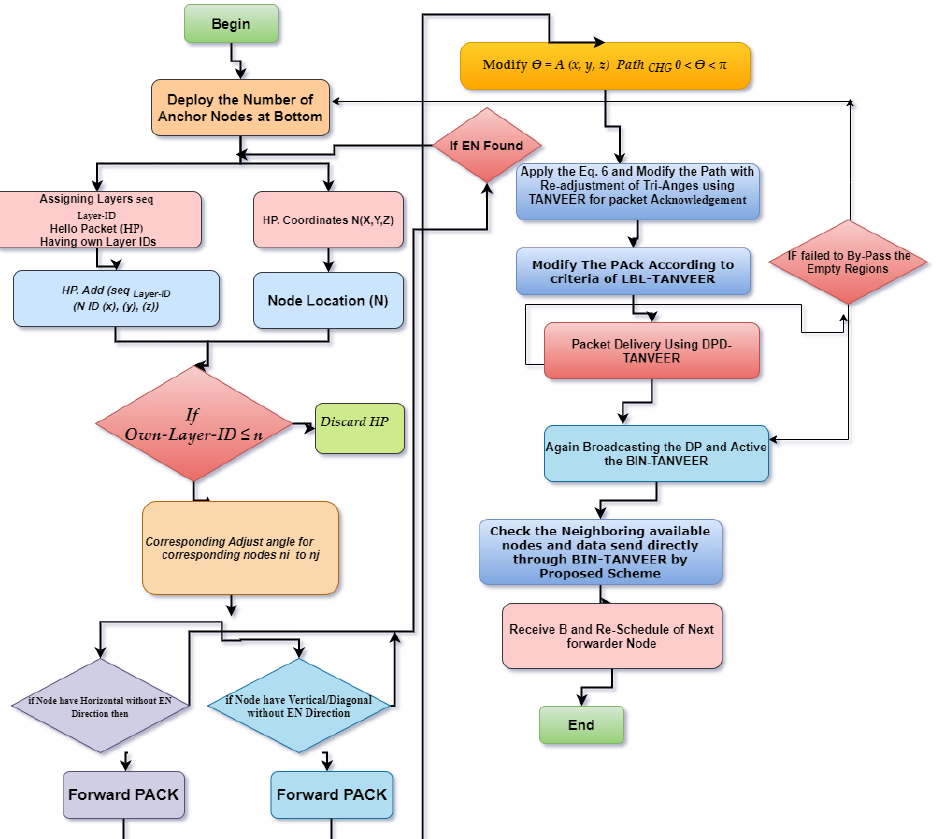
Figure 9. Flowchart of the proposed scheme.